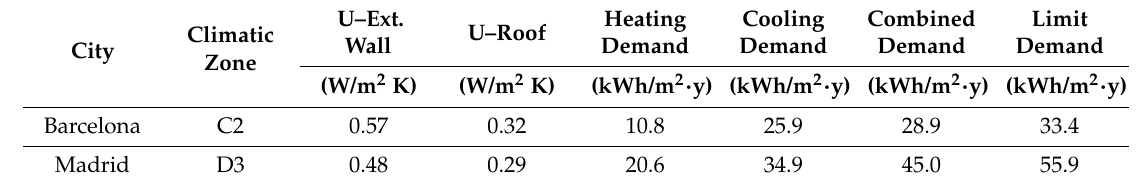
Table 1. Heat transfer coefficients and energy demand.